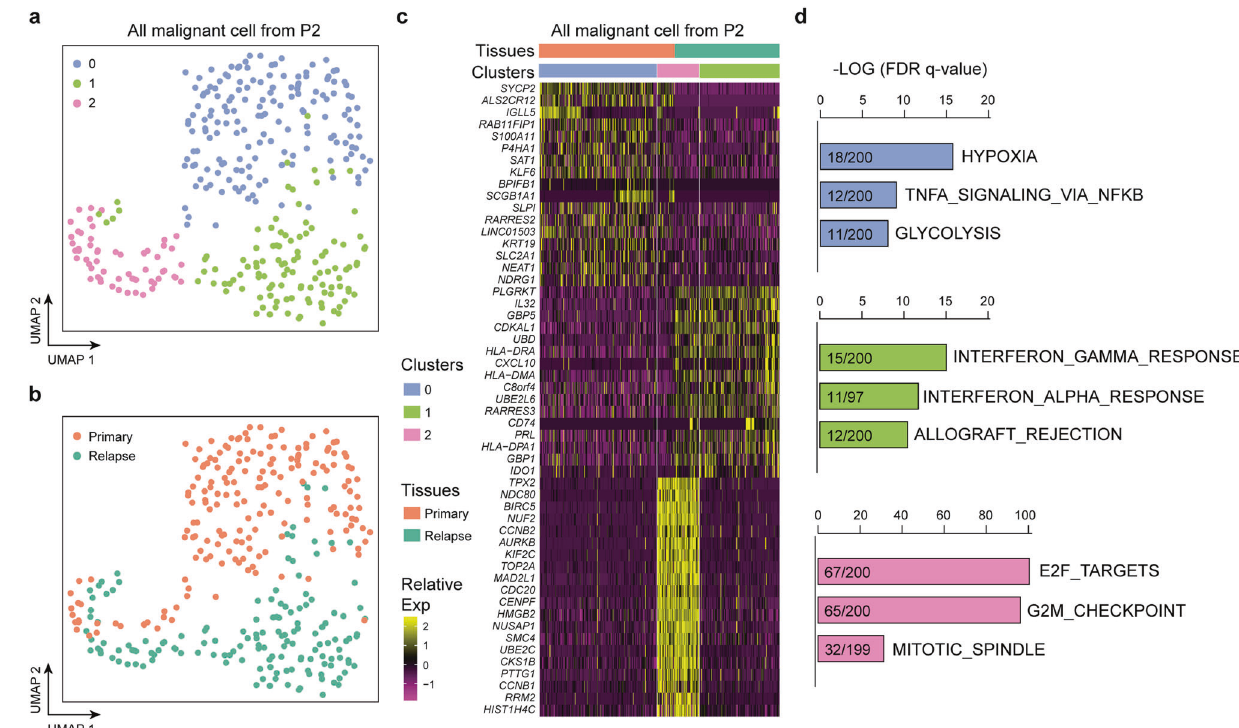
Fig. 6 ITH of SCLC is recapitulated in relapsed tumors. a UMAP plot of malignant cells from SCLC-P2 revealed three speci fi c clusters (indicated by color). b UMAP plot of malignant cells from SCLC-P2 revealed speci fi c clusters in the primary and relapsed tumors by the cell of origin. c Heatmap shows the DEGs and related pathways that correspond to the primary and relapsed tumors, as well as the three speci fi c clusters. d GSEA of all DEGs using hallmark gene set collections. The top 3 enriched hallmarks (ranked by the FDR q -values) along with the number of mapped and total genes in the pathways are